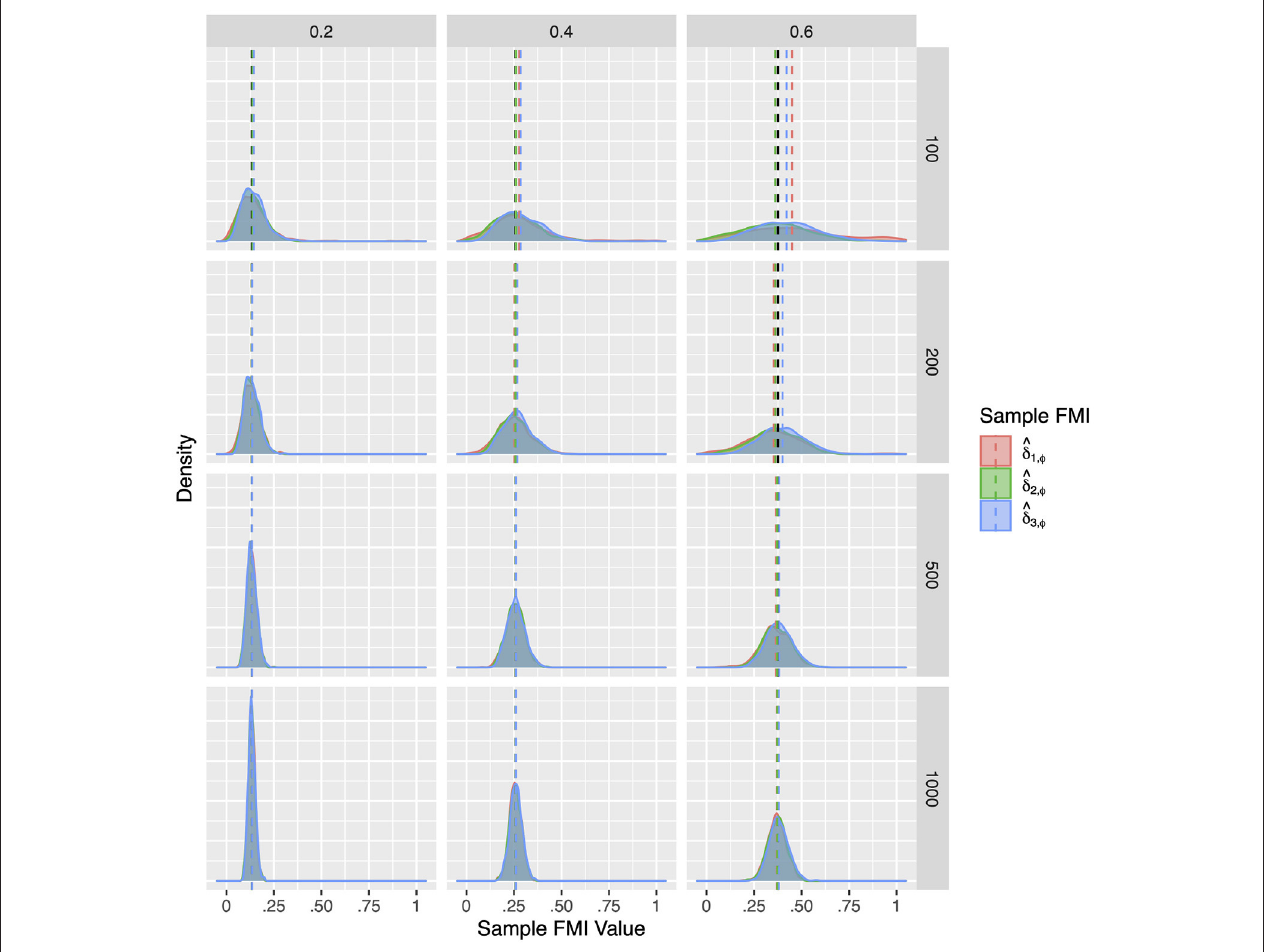
FIGURE 4 | The sampling distribution of FMI for factor correlations in MCAR. The panel rows correspond to sample sizes of N columns correspond to per variable missing rates of 20, 40, and 60%, or overall population missing rates of 10, 20, and 30%. The population FMI value in each panel is given as a vertical black dotted